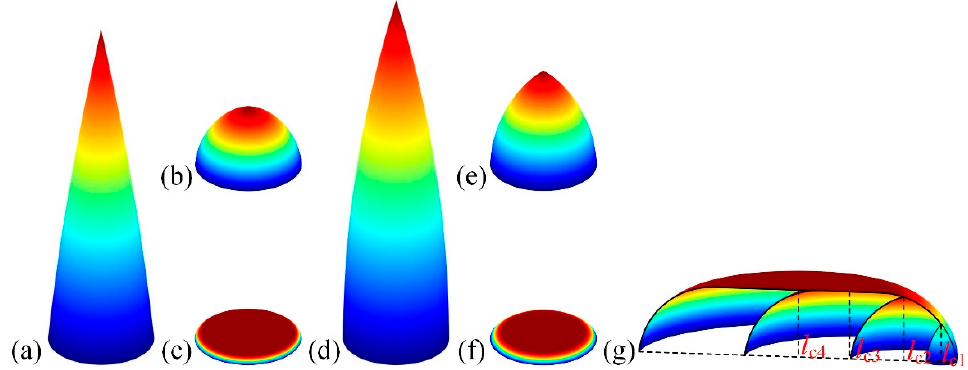
Figure 9. Effects of different parameters on steady-state ablation morphology of fibers: ( a ) η = 10, χ = 2.5 × 10 ‒ 5 m; ( b ) η = 10, χ = 5 × 10 ‒ 7 m; ( c ) η = 10, χ = 5 × 10 ‒ 8 m; ( d ) η = 200, χ = 5 × 10 ‒ 7 m; ( e ) η = 20, χ = 5 × 10 ‒ 7 m; ( f ) η = 2, χ = 5 × 10 ‒ 7 m; ( g ) effect of characteristic length on fiber morphology.